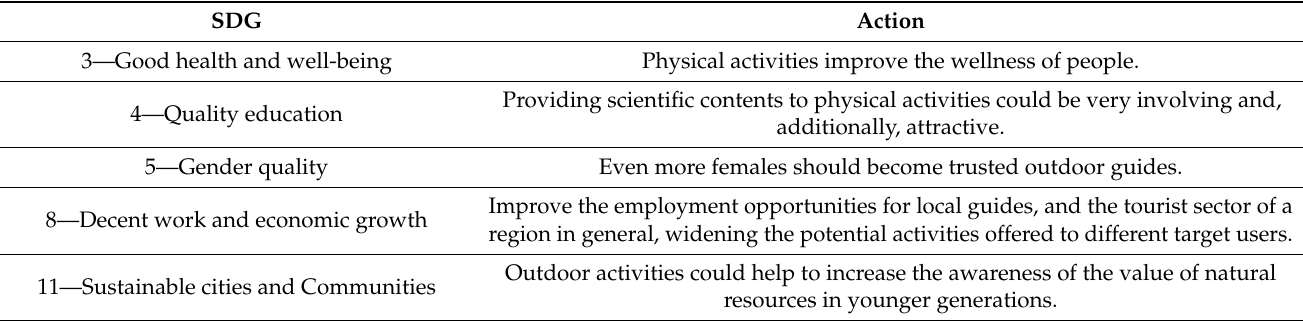
Table 5. How outdoor activities, and in the specific case, georafting and geocanyoning, could contribute to the achievement of some Sustainable Development Goals